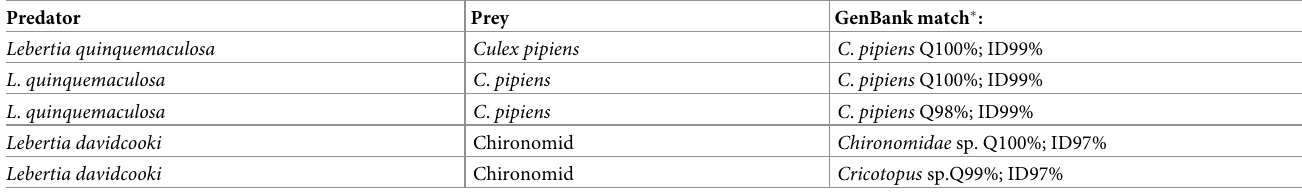
Table 2. Prey DNA in mites after laboratory